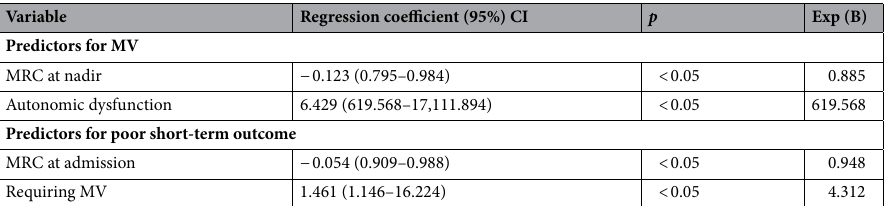
Table 5. Possible independent predictors for MV and poor short-term outcome in severe GBS by multivariate logistic regression. GBS: Guillain-Barré syndrome; MV: mechanical ventilation; MRC: Medical Research Council; CI: Confidence